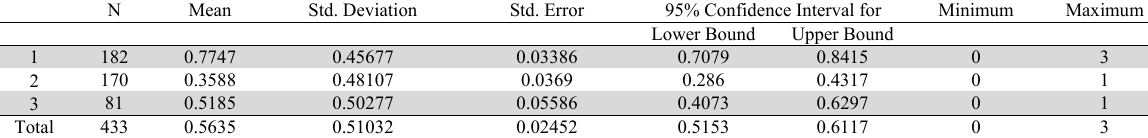
Descriptive for systems